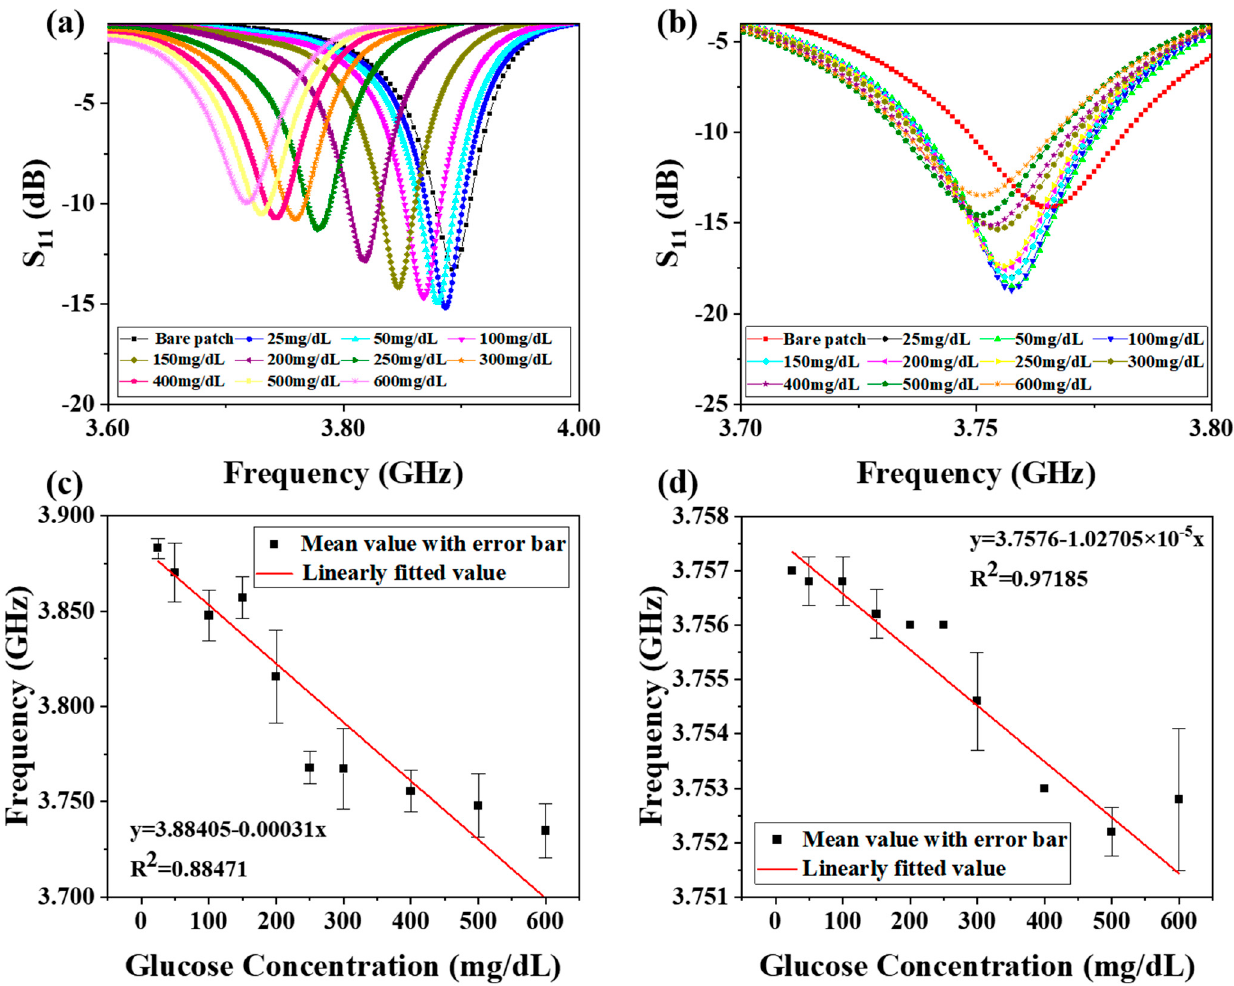
Figure 6. Measured S 11 for different concentrations of glucose sample solutions (25–600 mg/dL): ( a ) bare Reader and ( b ) RFID system. Linearly fitted resonant frequency, including the mean value of resonant frequencies with error bars. ( c ) Reader structure (R 2 = 0.88471, RSD < 1%) and ( d ) RFID system (R 2 = 0.97185, RSD < 1%). Table 1. Performance comparison with other previously reported methods. Ref.